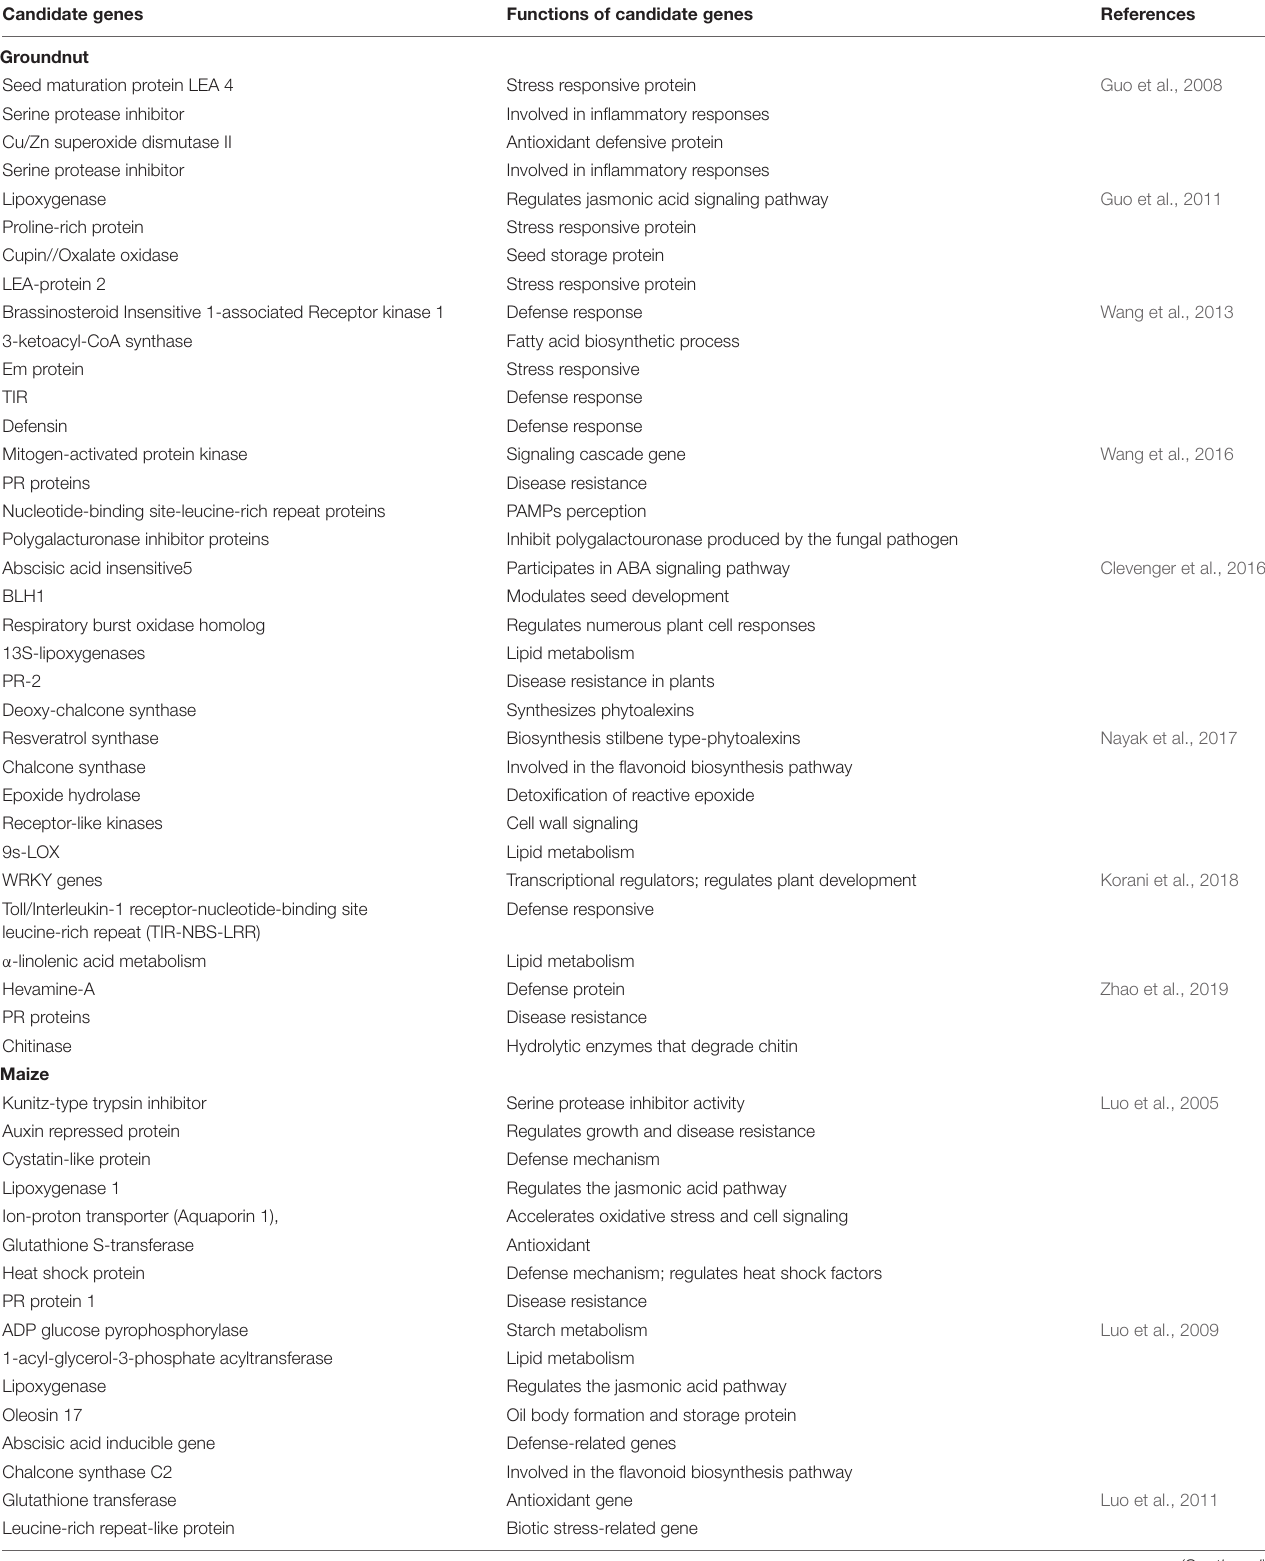
TABLE 3 | A summary of some transcriptomics studies to identify candidate genes involved in aflatoxin contamination in groundnut and